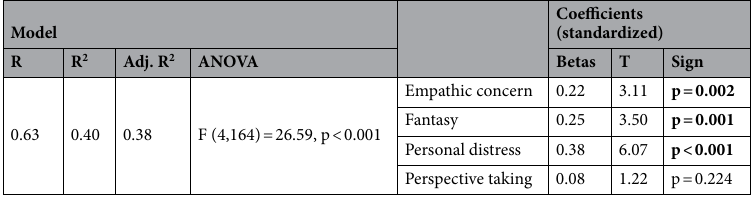
Table 3. Regression analyses of SPS with empathy personality measures (IRI subdimensions) as predictors. Significant values in